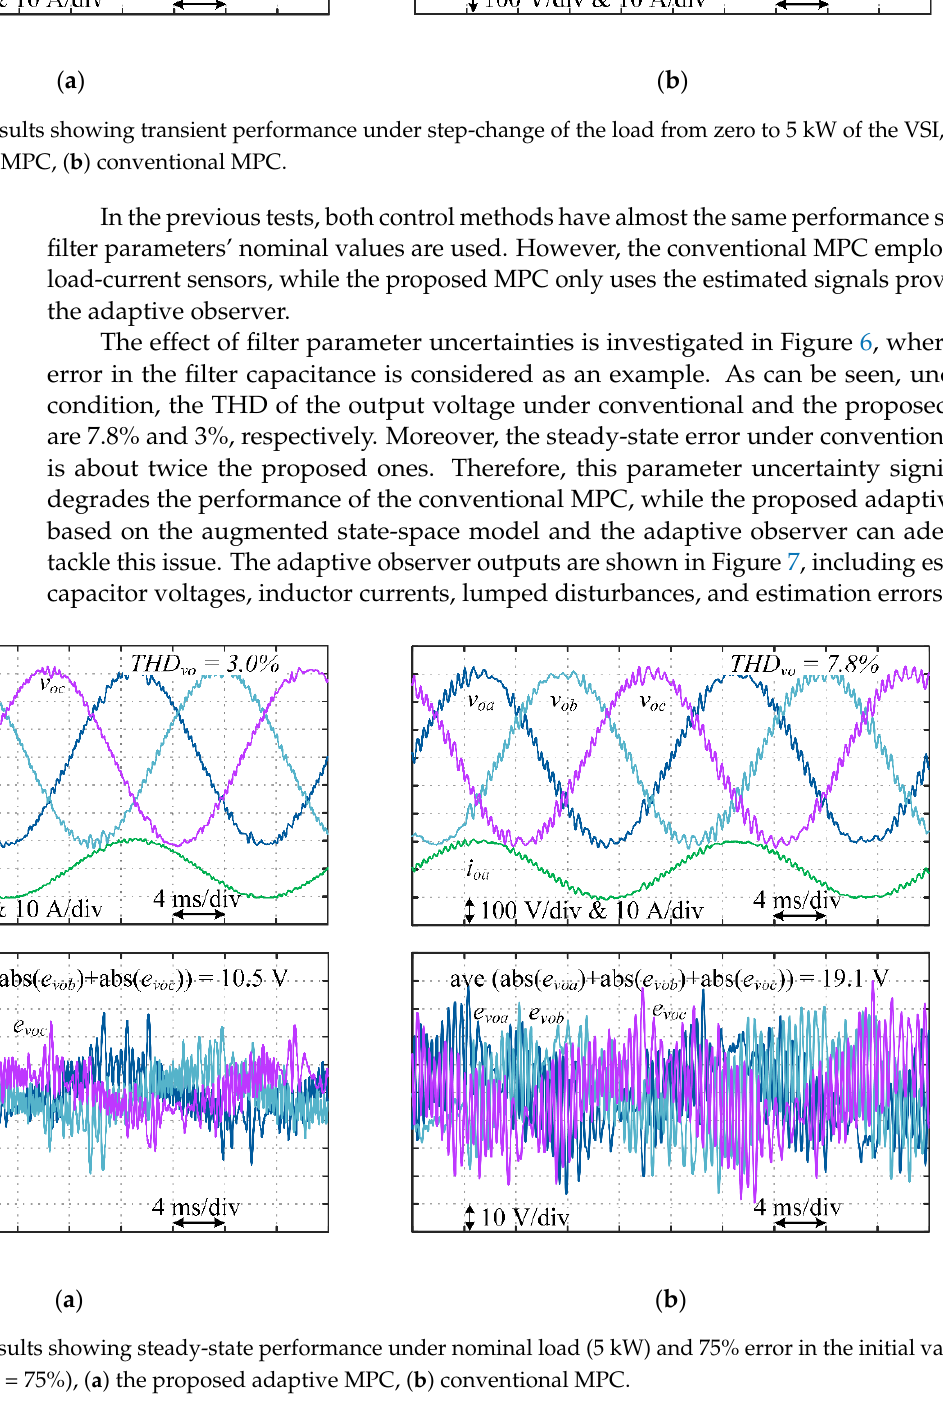
( d ) Figure 7. Simulation results showing outputs of the proposed adaptive observer under nominal load (5 kW) and 75% error in the initial value of filter capacitance ( e C = 75%), ( a ) estimated capacitor voltages and voltage estimation errors ( b ) esti- mated inverter currents and current estimation errors, ( c , d ) estimated disturbance inputs and disturbance estimation er- rors.